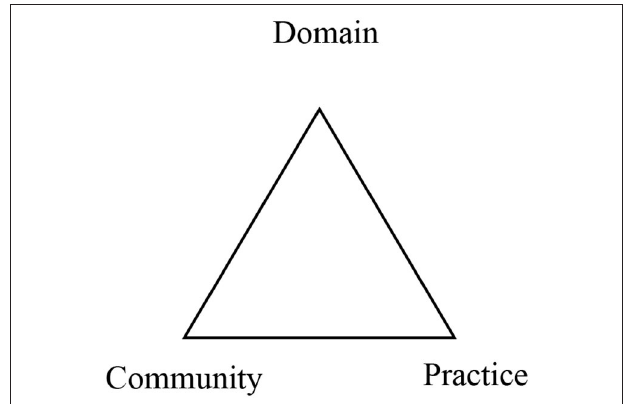
FIGURE 1 | The community of practice